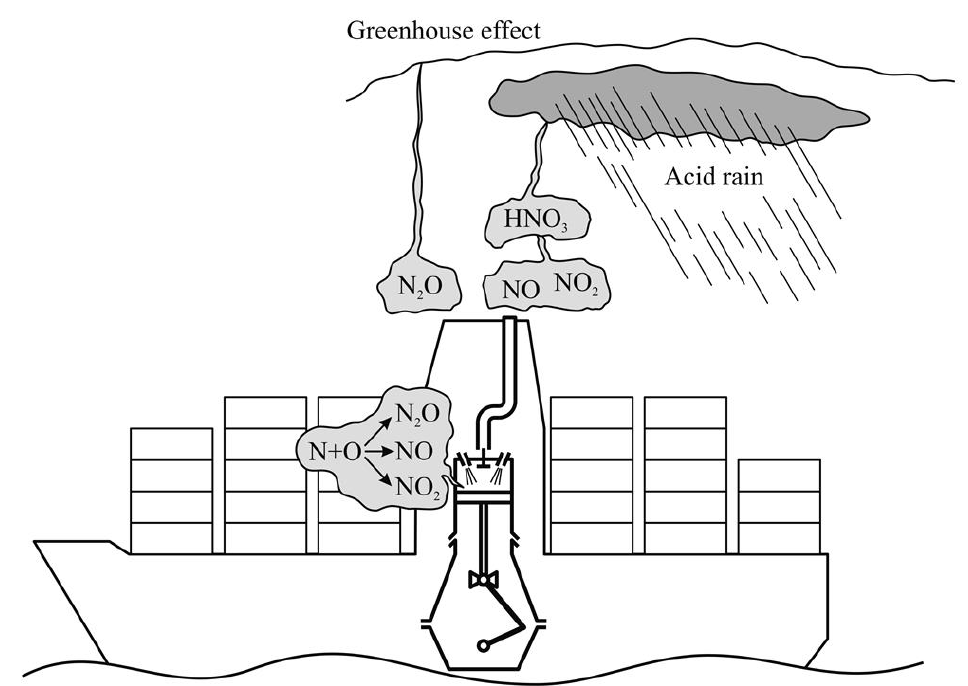
Figure 1. The impact of nitrogen oxides on the environment during the operation of marine diesel engines.